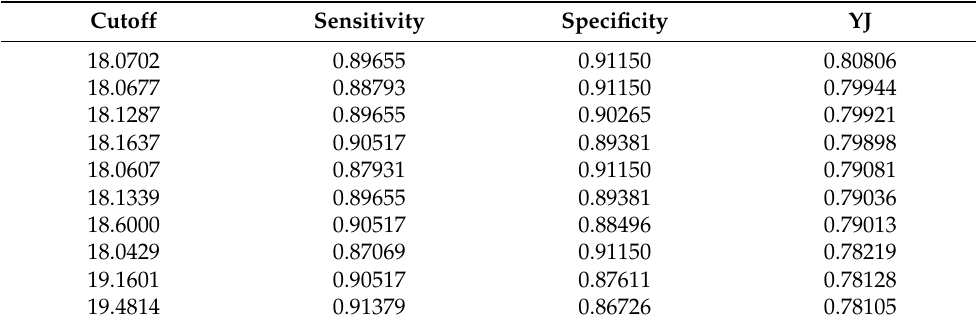
Table 5. Partial output of real-time LAMP quantification cycle (C q ) cutoff scores with statistics, sorting by highest Youden’s J